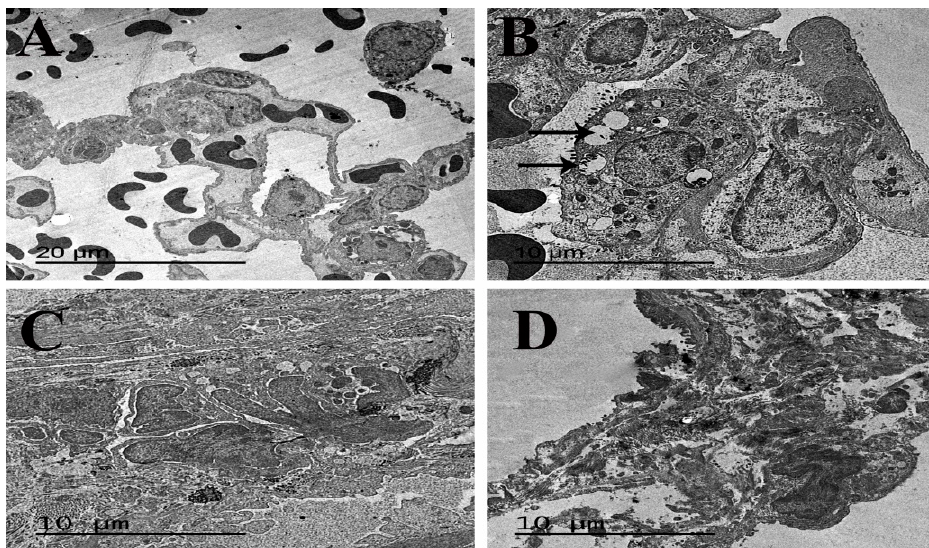
Figure 9. Representative electron micrograph for ultra-thin lung sections from Wister rats treated (via intratracheal instillation) with bleomycin, TQ-PLGA-PVA-NPs, or their combination. ( A ) Lung sections from control rats showing apparently normal pneumocytes and blood air barriers. ( B ) Lung sections from TQ-PLGA-PVA-NPs- treated rats showing active pneumocyte type II with prominent lamellar bodies with or without surfactant lamella (arrows). ( C ) Lung sections from bleomycin- treated rats showing the presence of an excessive amount of collagen fibers intermingled interstitially between proliferated cells. ( D ) Lung sections from bleomycin + TQ-PLGA-PVA-NPs treated rats showing collagenolysis and release of nanoparticles from ruptures pneumocytes within the alveolar septa (bar = 20 µ m for ( A ); bar = 10 µ m for ( B – D